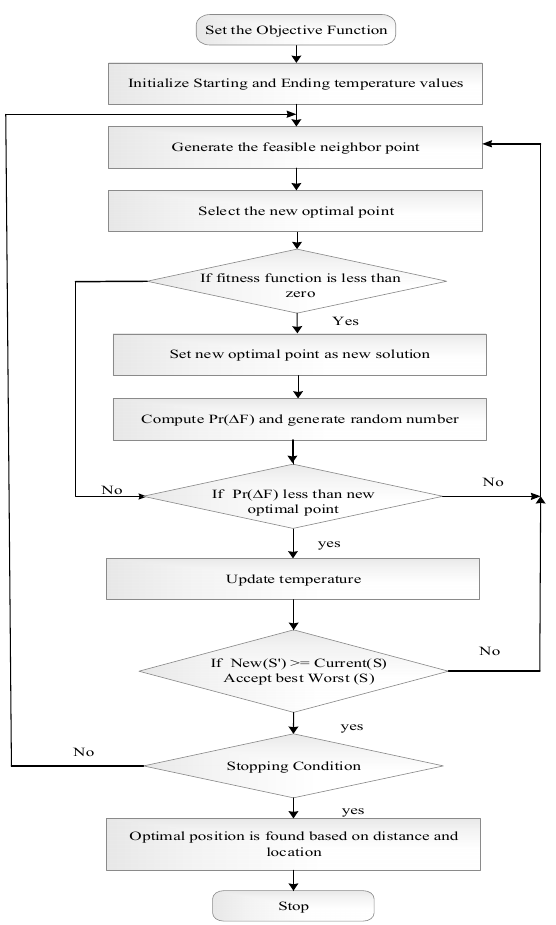
Figure 3. Flow chart of the SA-MCSDN algorithm.